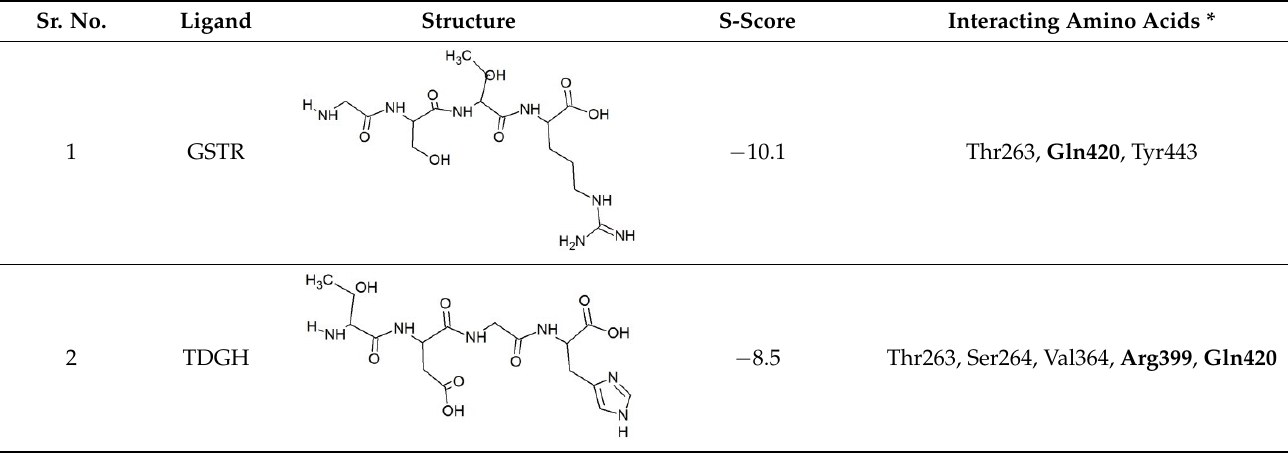
Table 1. Energy profiling of selected tetrapeptides as ligands of ORF2 (capsid protein) of HEV. Sr. No.